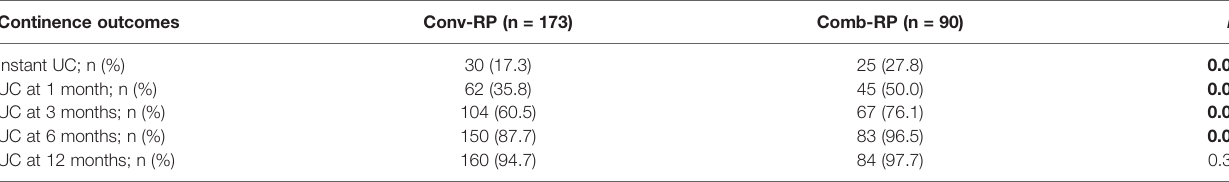
TABLE 4 | Continence outcomes of patients undergoing Conv-RP or Comb-RP. Continence outcomes